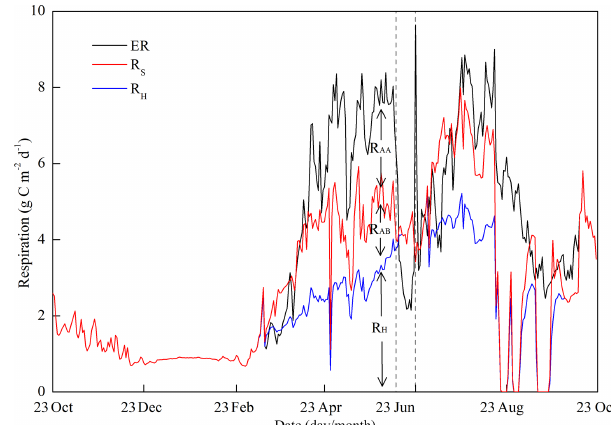
Figure 9. Seasonal variations in gross primary productivity (GPP), net ecosystem exchange (NEE) and ecosystem respiration (ER) (those before 2 April were calculated with the SVR method).